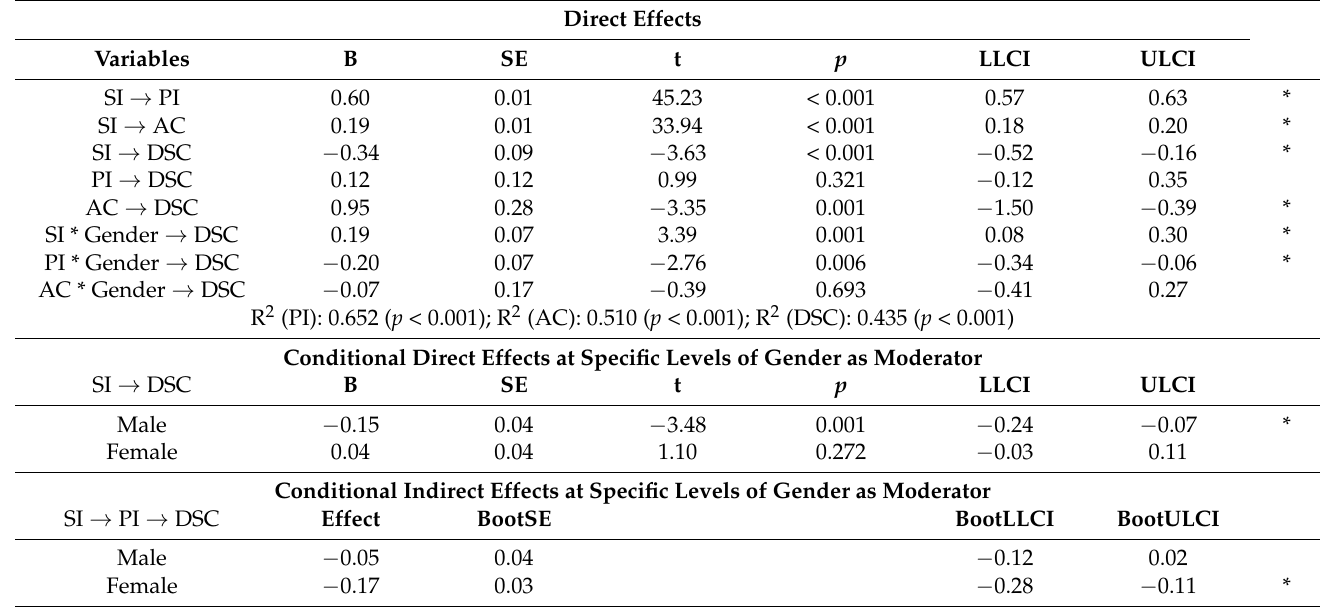
Table 5. Moderated mediation analysis when treating gender as a